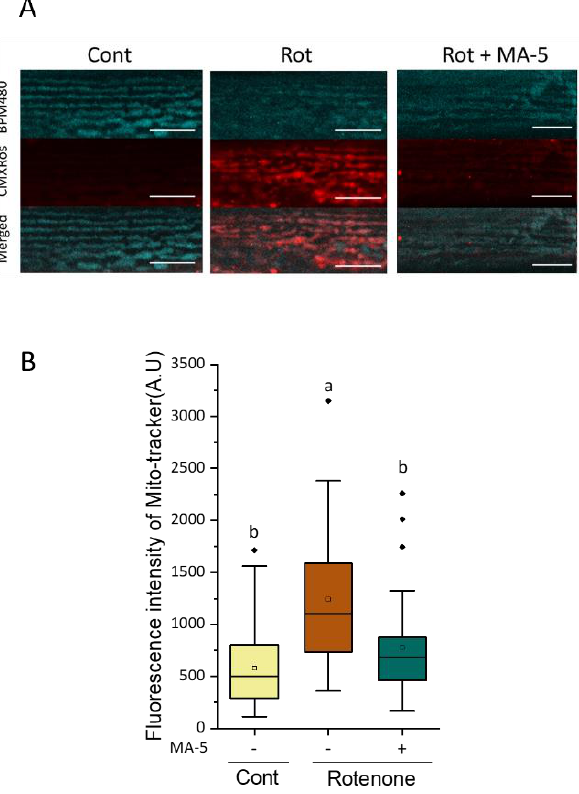
Figure 4. MA-5 suppressed rotenone-induced reactive oxygen species (ROS) levels after 6 h of treat- ment. Wild-type (N2) adult worms treated with rotenone applied with or without MA-5 on day 2. ( A ) Representative images of mitochondria stained by AIE™ Mitochondria Blue (indicated as blue) and MitoTracker ® Red CMXRos (indicated as red) and merged (scale bar: 10 µ m). MitoTracker ® Red CMXRos was applied to evaluate the mitochondrial site of ROS generation and AIE™ Mitochondria Blue to determine the mitochondrial location in body muscle cells. ( B ) The intensity of MitoTracker ® Red CMXRos fluorescence as an indicator of ROS production ( n ≥ 30 mitochondria from 6–14 worms/treatment). Data are shown as box plots to indicate median (central line) and mean (square mark). Different letters indicate significant differences ( p ≤ 0.05) using Dunn’s test with all data points including outliers. Cont: control treated with 0.6% of DMSO; MA-5: 10 µ M; Rot: 2 µ M Rotenone; Mitoblue: AIE™ Mitochondria Blue; CMXRos: MitoTracker ® Red CMXRos; Diamond mark: outlier data.